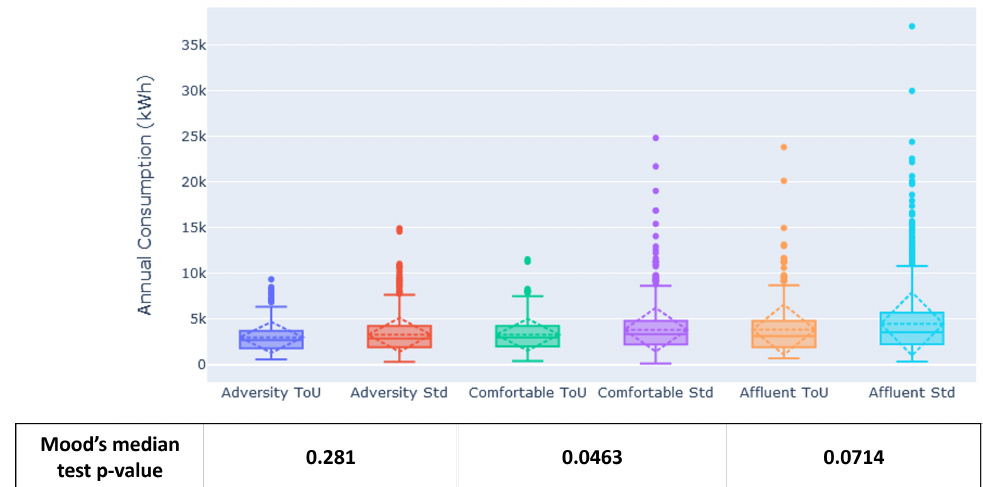
Figure 1. Annual consumption distribution per ACORN group.